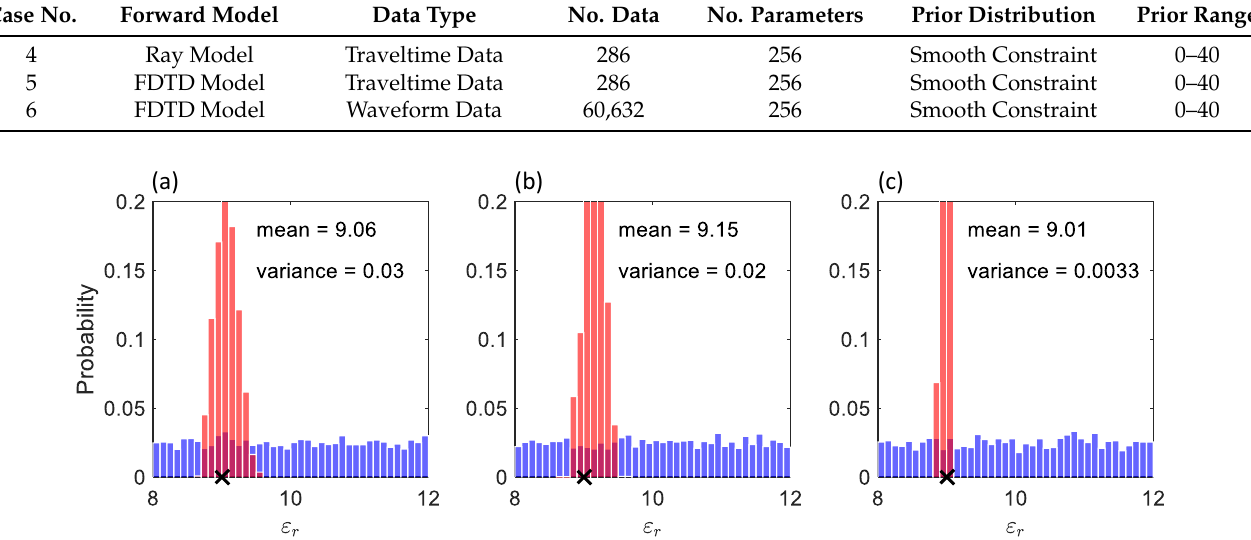
Table 2. Bayesian inversion parameters using smooth constraint as prior information.